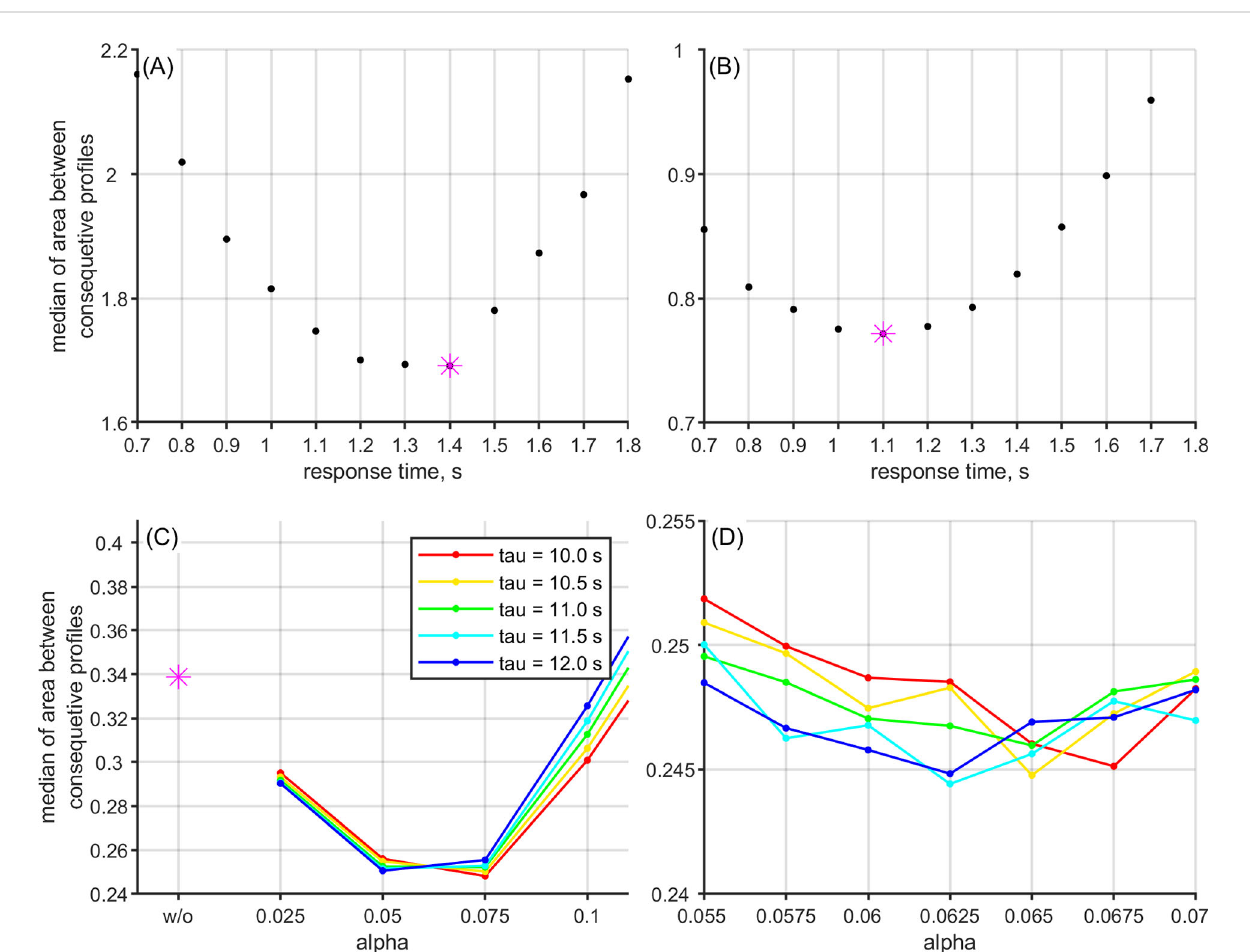
FIGURE 10 (A, B) The change in the median of the mean area between pro fi les as response time correction was applied respectively for temperature and conductivity. The optimal time shift is shown with magenta star. (C, D) The change in the median of the mean area between pro fi les as thermal lag correction was applied with respect to the one calculated based on the raw data (magenta). The median value decreases at fi rst as a tl increases. Colored lines correspond to t tl values from 10 to 12 s with 0.5 s step. The optimal combination of a tl and t tl were chosen near minimal median value (D)